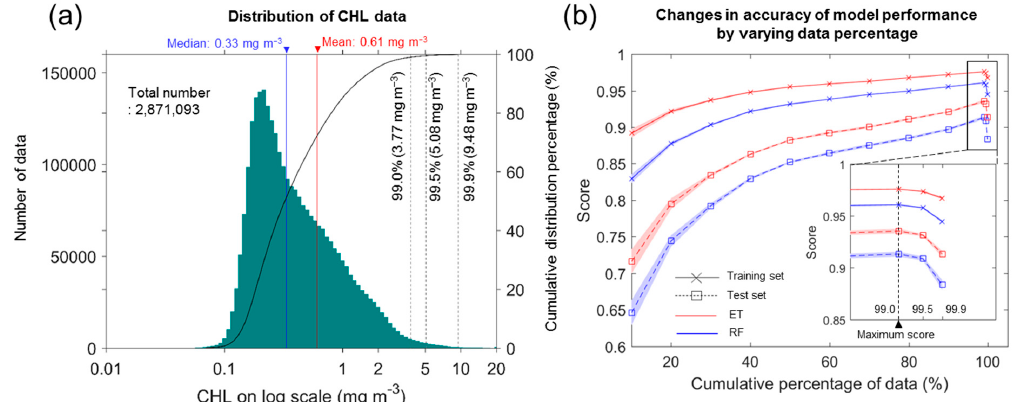
Figure 4. ( a ) Histogram of CHL data to be trained (green bars) and the cumulative percentage of data distribution (black curve). There are 2,417,932 data (train and test data), and the dotted lines indicate the location of the cumulative proportion of 99.0%, 99.5%, and 99.9%, respectively. The bars refer to the left axis. The curve refers to the right axis. ( b ) Score changes in the RF (blue) and ET (red) model performance by varying the thresholds associated with the increasing percentage of data. The error bar indicates the confidence interval (95%) estimated from the results by the 10-fold cross-validation.